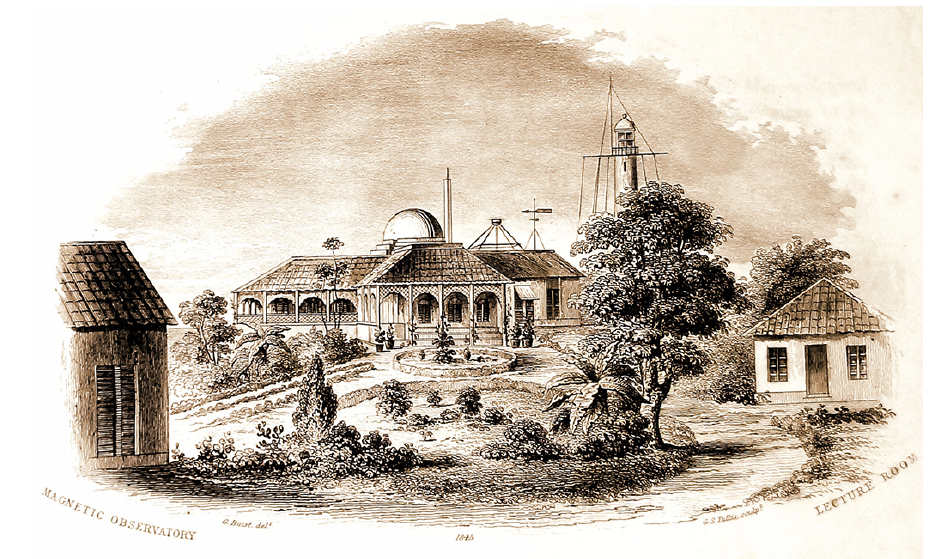
Figure 3. Photograph from the cover of the provisional report on the meteorological observations made at Colaba, Bombay, for the year 1844. The magnetic observations were carried at the far left end of the photograph partially depicting a hut. The lighthouse and dome are seen in the